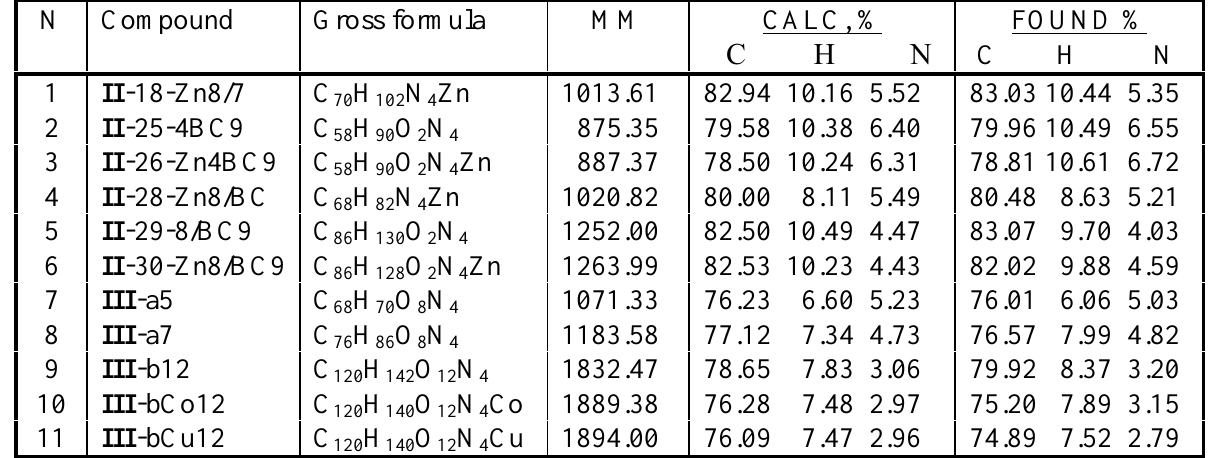
Table 6. Elemental analysis data of compounds II , III